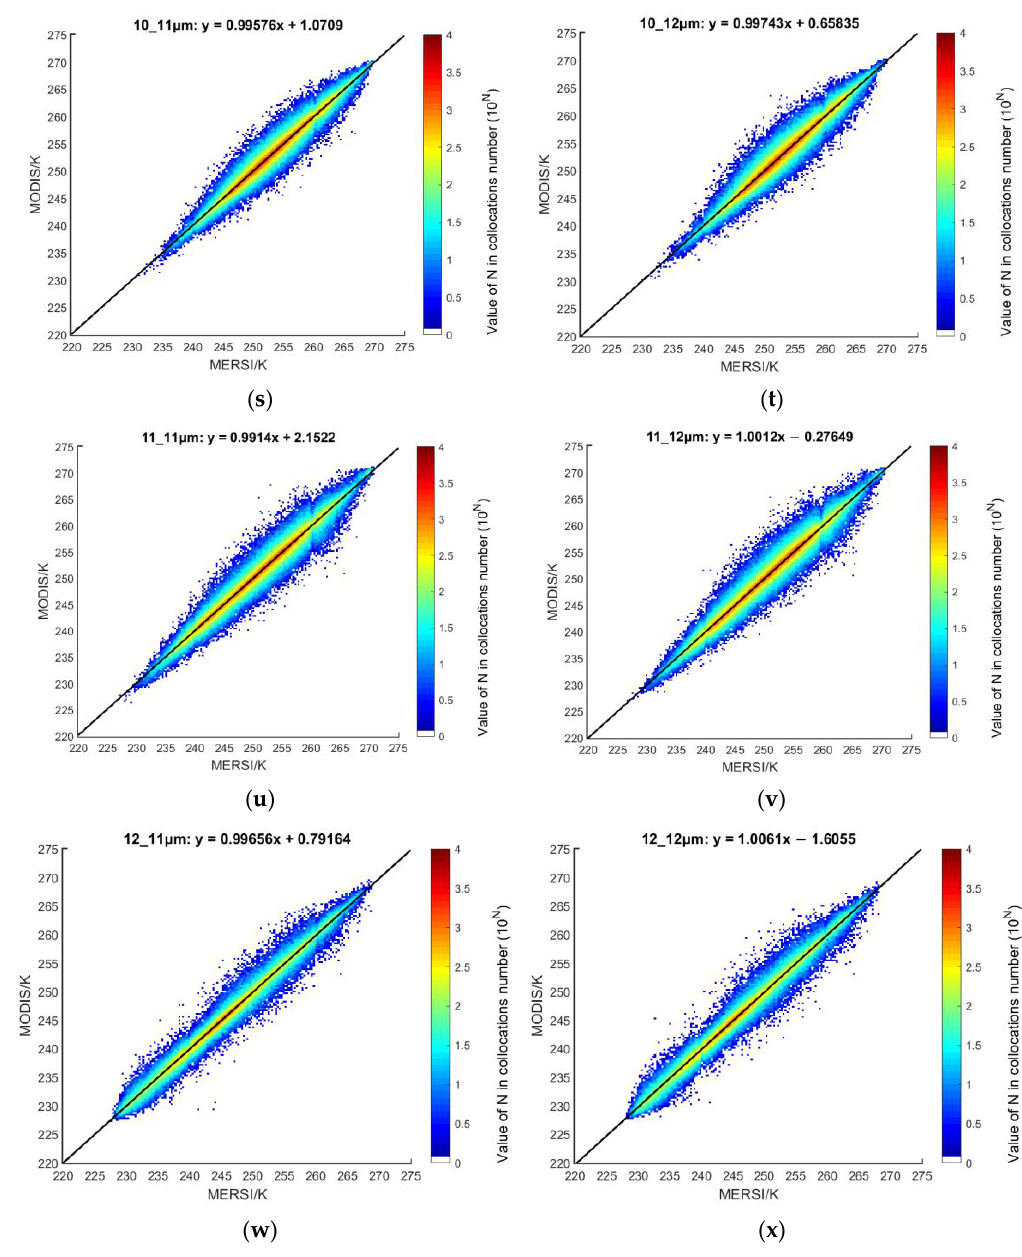
Figure 5. Cross-calibration of the FY-3D/MERSI and Aqua/MODIS thermal infrared T b data for each month. ( a ) 11 January µ m. ( b ) 12 January µ m. ( c ) 11 February µ m. ( d ) 12 February µ m. ( e ) 11 March µ m. ( f ) 12 March µ m. ( g ) 11 April µ m. ( h ) 12 April µ m. ( i ) 11 May µ m. ( j ) 12 May µ m. ( k ) 11 June µ m. ( l ) 12 June µ m. ( m ) 11 July µ m. ( n ) 12 July µ m. ( o ) 11 August µ m. ( p ) 12 August µ m. ( q ) 11 September µ m. ( r ) 12 September µ m. ( s ) 11 October µ m. ( t ) 12 October µ m. ( u ) 11 November µ m. ( v ) 12 November µ m. ( w ) 11 December µ m. ( x ) 12 December µ m. Table 3 shows the coefficients of the regression equation for each month. For 11 µ m, the slope ranges from 0.9309 to 1.0009, and the intercept ranges from − 0.0622 K to 18.8584 K. For 12 µ m, the slope ranges from 0.9142 to 1.0061, and the intercept ranges from − 1.6055 K to 23.0954 K. The intercept is greater in June and July. Using Equations (5) and (6), we obtained the thermal infrared channel T b data after MERSI calibration.